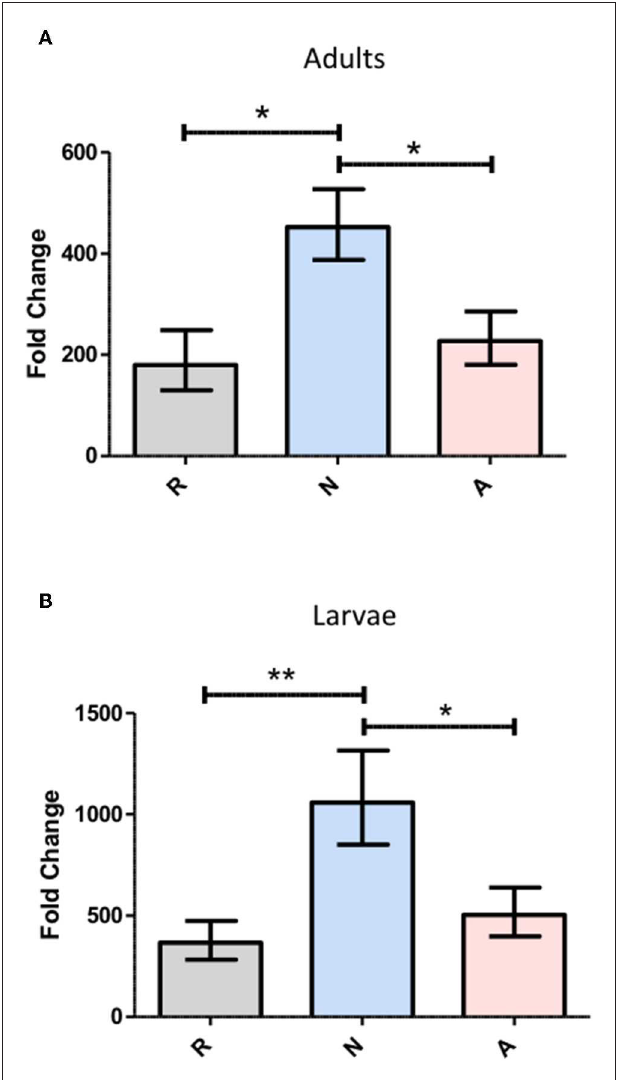
FIGURE 2 | Heterorhabditis bacteriophora nematode Excreted/Secreted (ES) products elicit differential Diptericin responses that are consistent across Drosophila melanogaster life stages. D. melanogaster adults (A) and 3rd instar larvae (B) were injected with 69.0 and 50.2 nl of non-activated (N) or activated (A) concentrated ES products, representing 138 and 100 infective juvenile equivalents, respectively. An equivalent volume of Ringer’s buffer (R) served as a control. Flies and larvae were homogenized at a 6-h time point before RNA isolation, cDNA conversion, and transcript abundance quantification of the antimicrobial peptide Diptericin by qPCR. Fold change is relative to 0-h expression immediately following injection with each treatment and values represent data from three trials at two technical replicates per trial, where replicate measurements are drawn from the pooled cDNA of five flies or larvae (* p < 0.05, ** p <